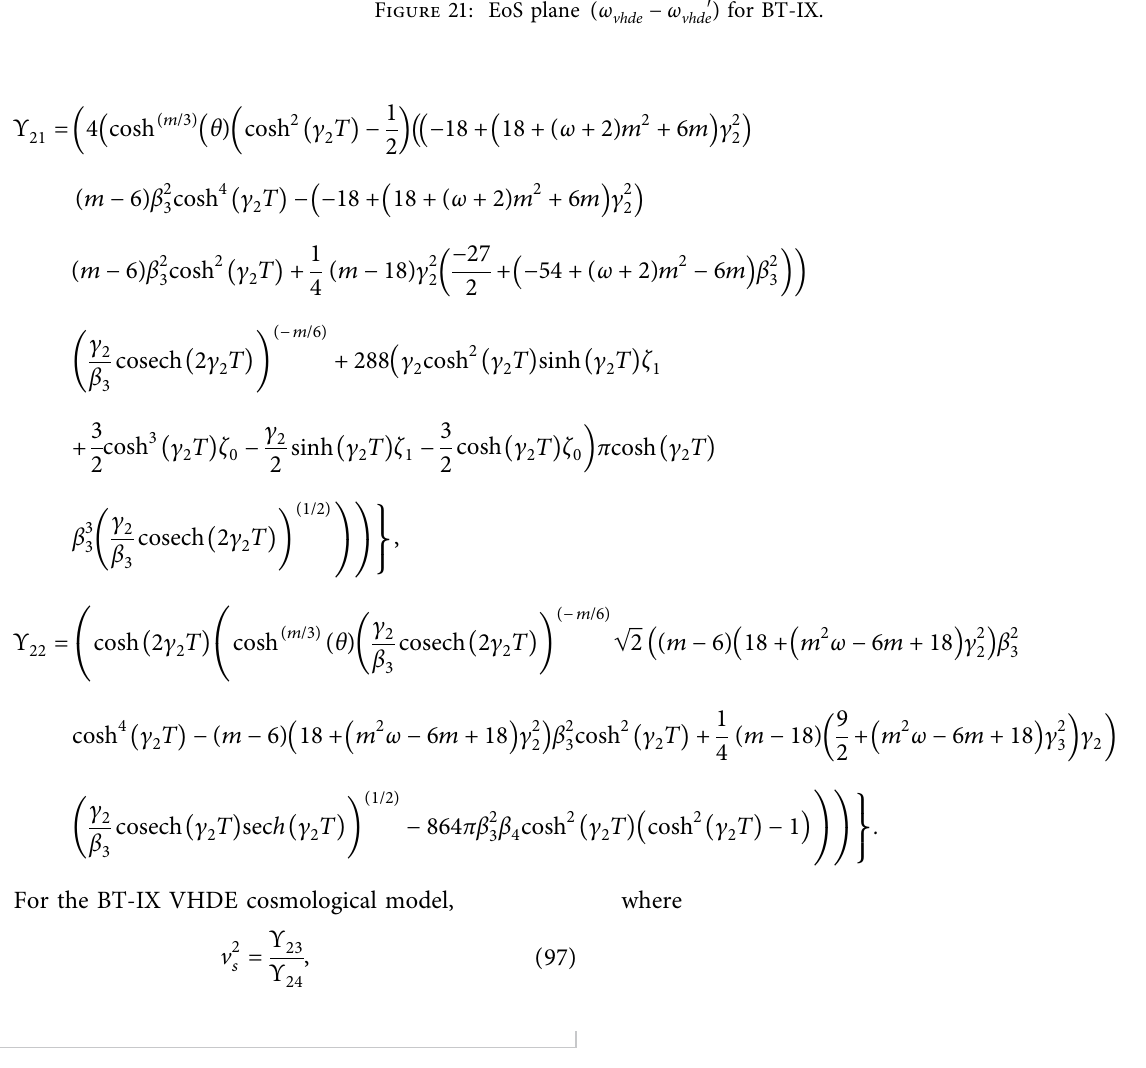
− ω ) for vhde vhde ′